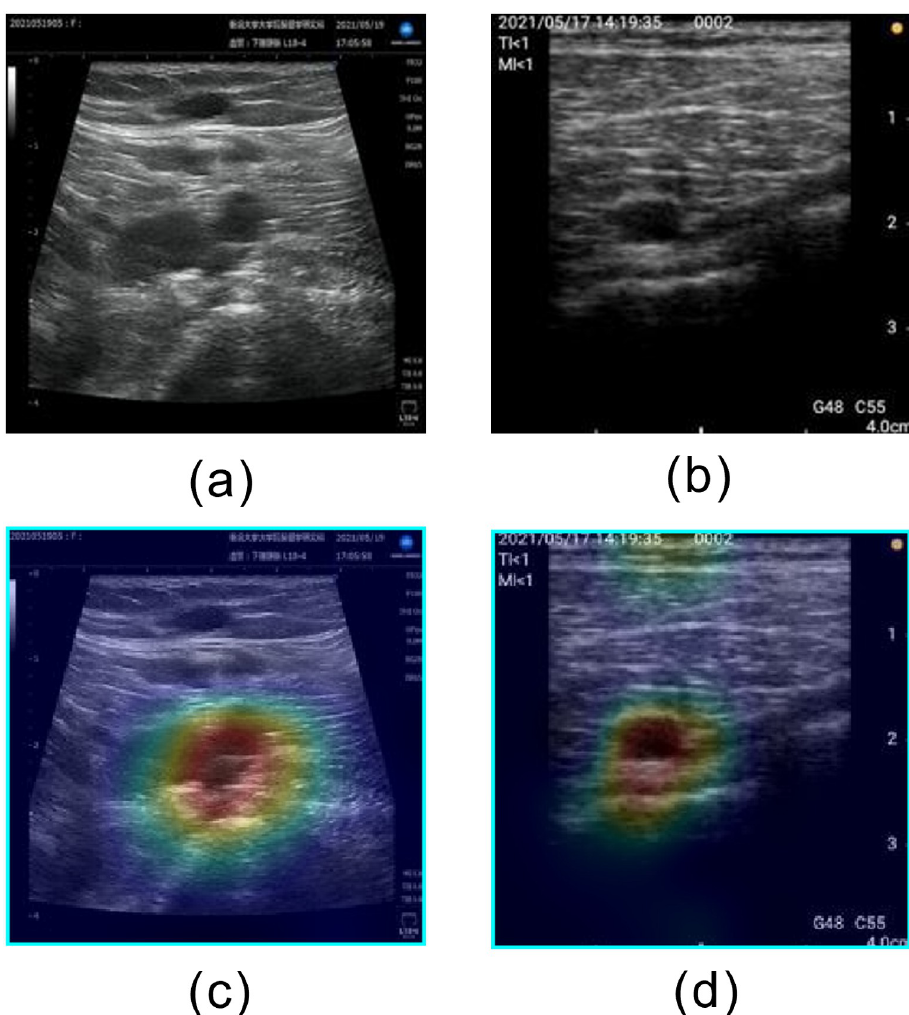
Fig 10. Examples of Moderately Satisfactory images misclassified as satisfactory images and the corresponding heatmap images. (a) Long axis acquired by stationary ultrasonography equipment, (b) Long axis acquired by Portable ultrasonography equipment, (c) Long axis acquired by stationary ultrasonography equipment, and (d) Long axis acquired by portable ultrasonography